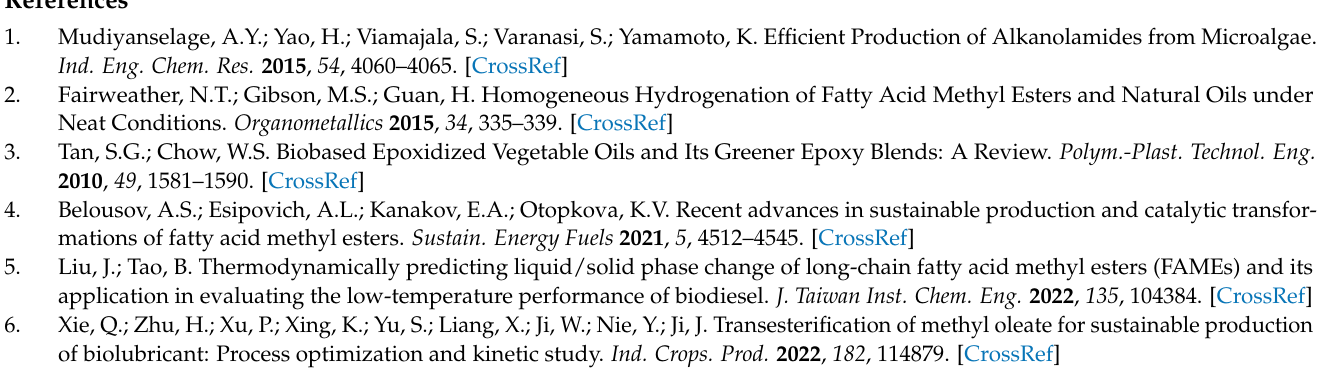
Figure S2: SEM images of (a,b) PW12@MIL-100(Cr); Figure S3: SEM images of (a,b) PW4@MIL- 100(Cr); Figure S4: EDS analysis of PW12@MIL-100(Cr); Figure S5: EDS analysis of PW4@MIL- 100(Cr); Figure S6: N 2 isotherm adsorption of MIL-100(Cr); Figure S7: N 2 isotherm adsorption of PW12@MIL-100(Cr); Figure S8: N 2 isotherm adsorption of PW4@MIL-100(Cr); Figure S9: N 2 isotherm adsorption of PW4@MIL-100(Cr) after 1 cycles; Figure S10: N 2 isotherm adsorption of PW4@MIL-100(Cr) after 5 cycles; Figure S11: Mass spectrum of FAME oxidation products (GC- MS). (a) methyl 5-oxo-octadecanoate, (b) Methyl 9-oxononanate, (c) methyl 10-oxo-octadecanoate; Figure S12: Mass spectrum of FAME Oligomerization products (HPLC-MS). Mass spectrum (positive) of peaks with a retention time of 25.5 min; 25.9 min; 26.2 min; 26.9 min: 28.5 min; Figure S13: Mass spectrum of methyl stearate oxidation products (GC-MS). (a) methyl